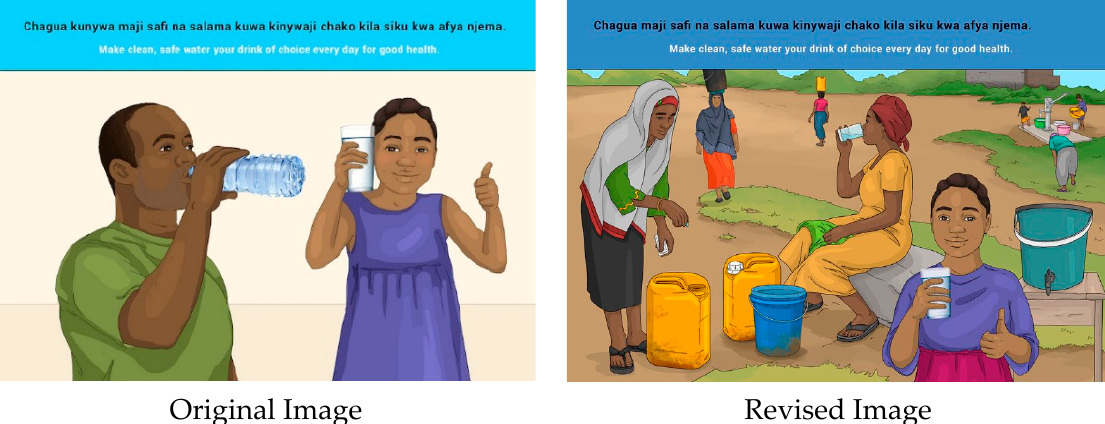
Figure 17. Make clean, safe water your drink of choice every day for good health.